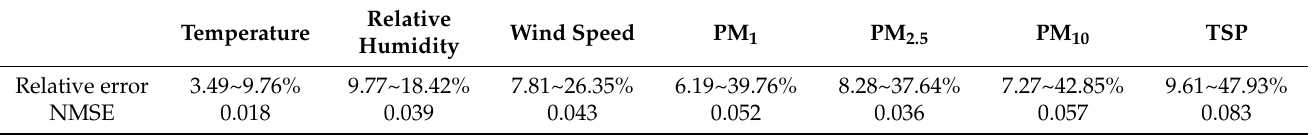
Table 5. The relative error and normalized mean squared error (NMSE) value of temperature, relative humidity, wind speed, and PM concentration (outside).